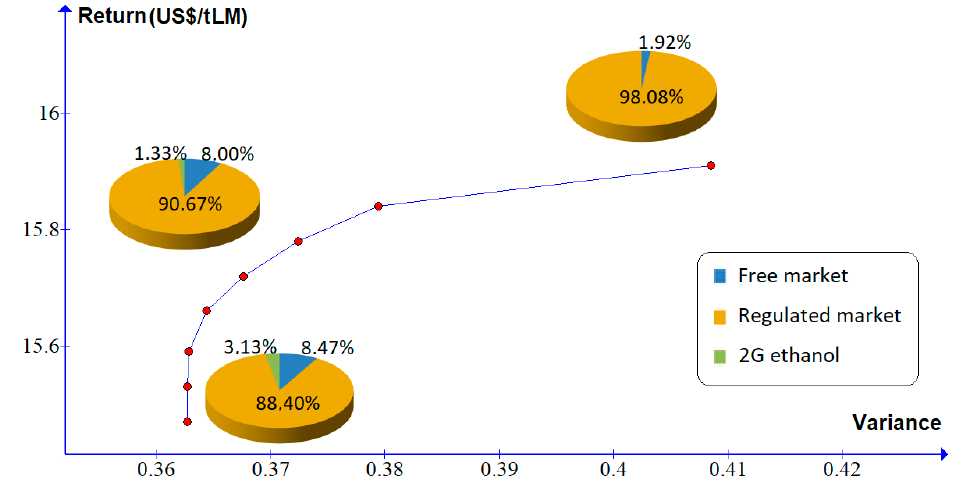
Figure 4. Efficient frontier for scenario 2.